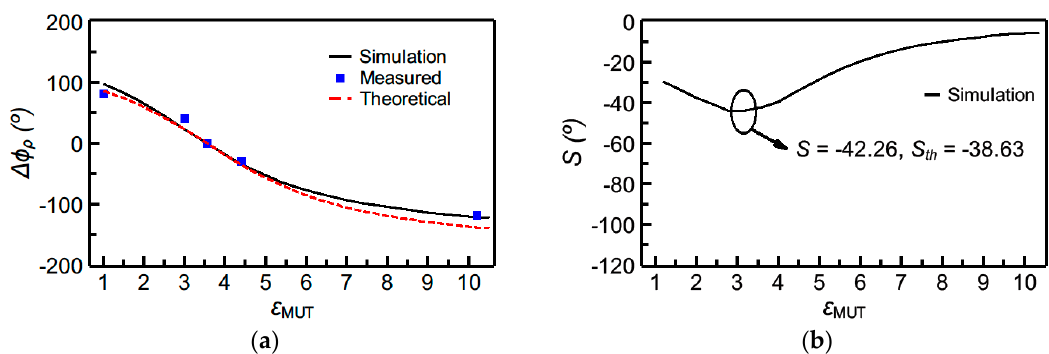
Figure 4. Dependence of the differential phase of the reflection coefficient (i.e., ∆ ϕ ρ = ϕ ρ − ϕ ρ , REF ) with the dielectric constant of the MUT ( a ) and sensitivity ( b ) for sensor A. The measured data points were obtained by covering the sensing line with the following uncoated materials: Rogers RO3010 ( ε MUT = 10.2), FR4 ( ε MUT = 4.4), Rogers RO4003C ( ε MUT = ε REF = 3.55), PLA ( ε MUT = 3.0, and fabricated by means of a 3D printer). Additionally, the phase of the reflection coefficient was experimentally obtained with the sensing line uncovered ( ε MUT , air = 1).